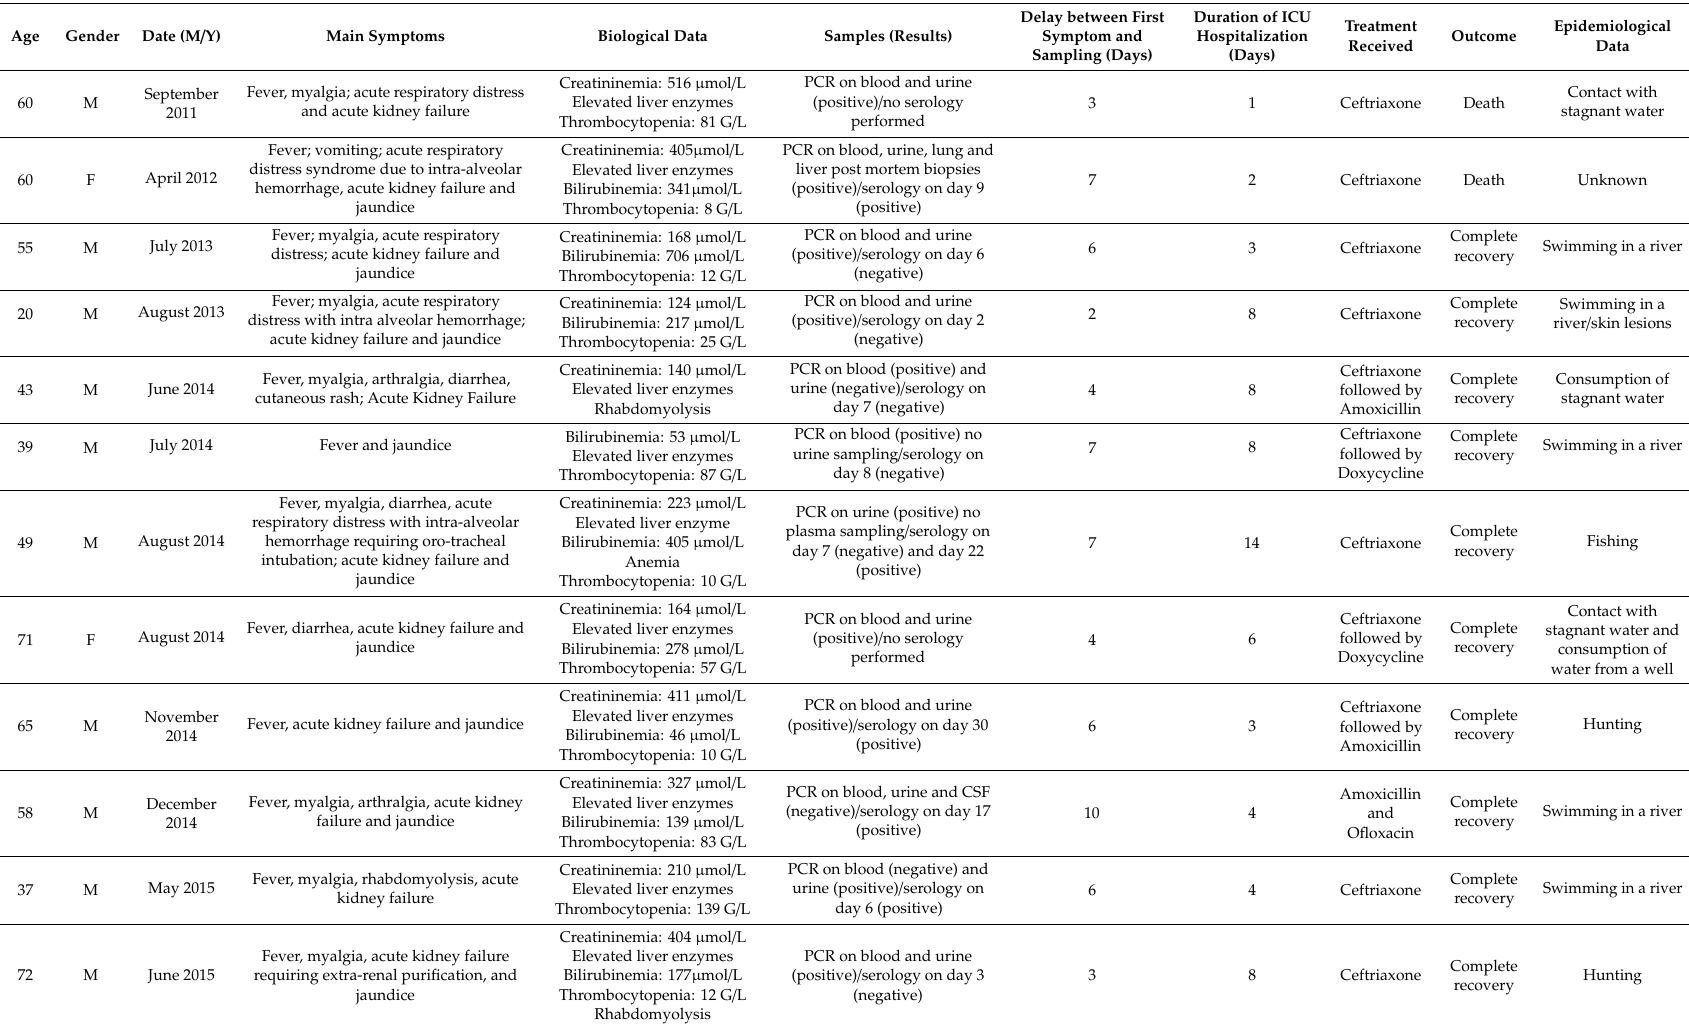
Table 1. Main characteristics of patients hospitalized in ICU with a confirmed leptospirosis